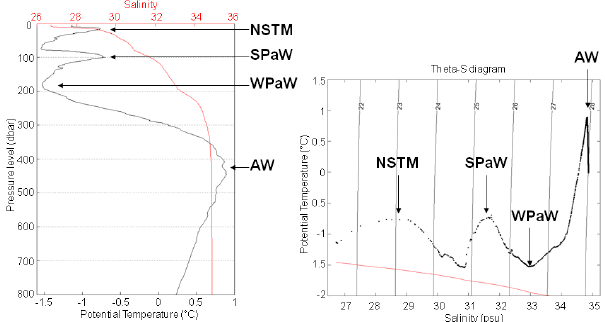
Figure 6: A typical vertical potential temperature and salinity profile of the study area (left) Fig. 6. A typical vertical potential temperature and salinity profile of and the corresponding θS diagram (right) with the freezing point indicated in red. The NSTM (Near Surface Temperature Maximum), the SPaW (Summer Pacific water), the WPaW the study area (left) and the corresponding θS diagram (right) with (Winter Pacific water) and the AW (Atlantic water) are indicated. This profile was recorded in the freezing point indicated in red. The NSTM (near-surface tem- August 2008 during the CHINARE campaign, at location [76.98°N, 146.1°W]. perature maximum), the SPaW (summer Pacific water), the WPaW (winter Pacific water) and the AW (Atlantic water) are